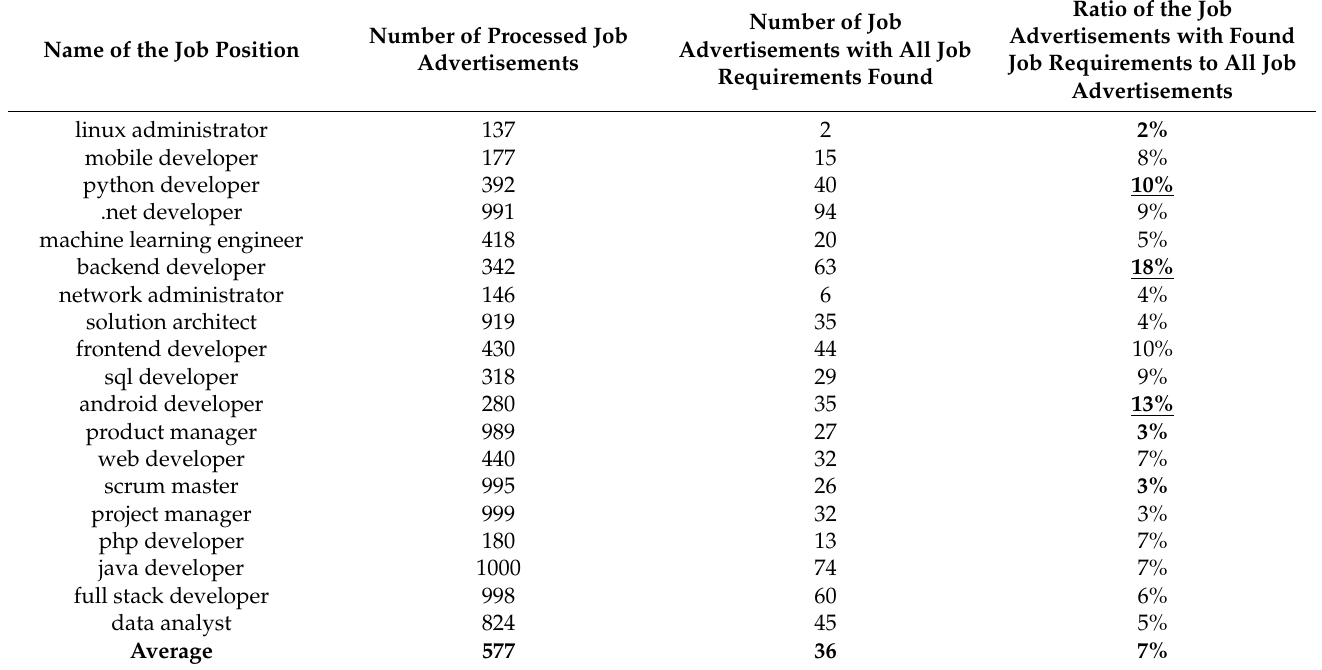
Table 2. Results of processing job advertisements using the basic machine learning